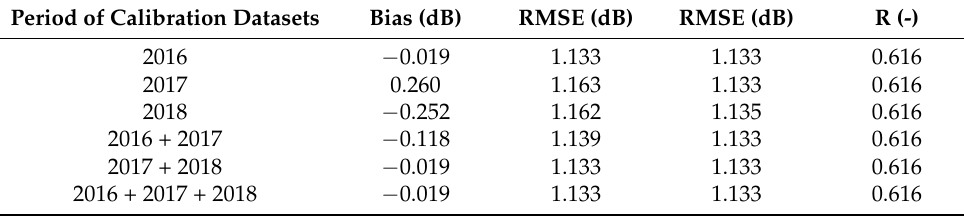
Figure 4. The effective roughness parameters computed at different temporal stages. The black lines represent the diagonal, which is the slope of 0.086. The circles with red, green, blue, magenta, cyan, and black color stand for the smallest five RMSE S1A_AIEM computed in 2016, 2017, 2018, 2016 + 2017, 2017 + 2018, and 2016 + 2017 + 2018, respectively. The digit number represents the order. Table 4. Evaluation metrics between the Sentinel-1A backscatter and AIEM simulation. Table 3. Effective roughness parameters optimized at different temporal periods. Period of Calibration